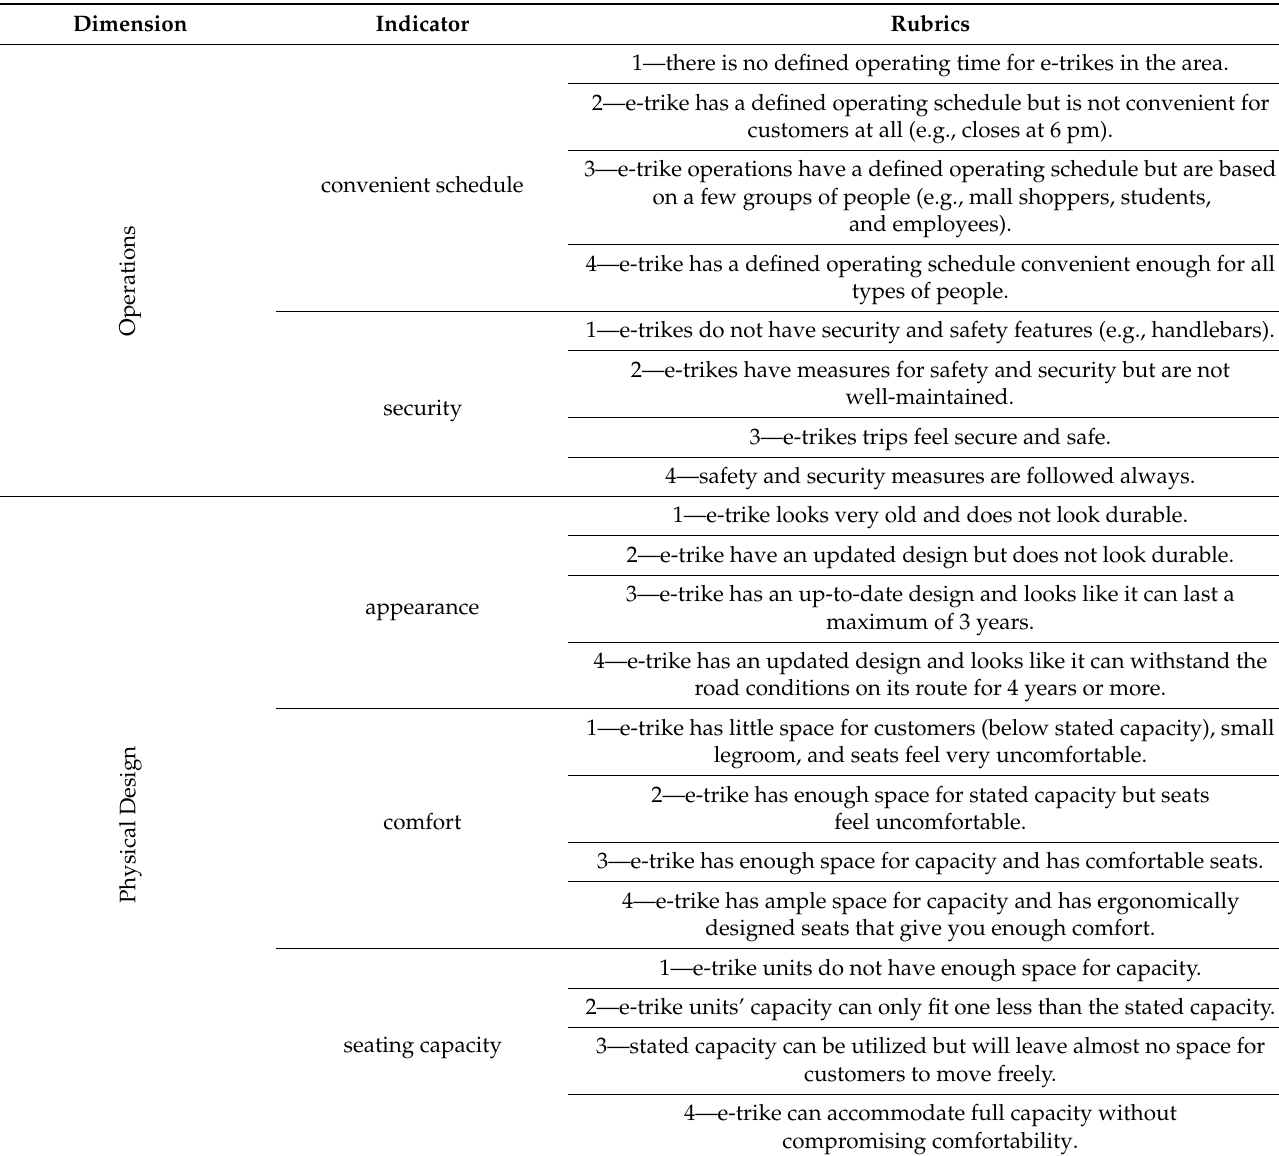
Table 6. Rubrics for e-trike service quality